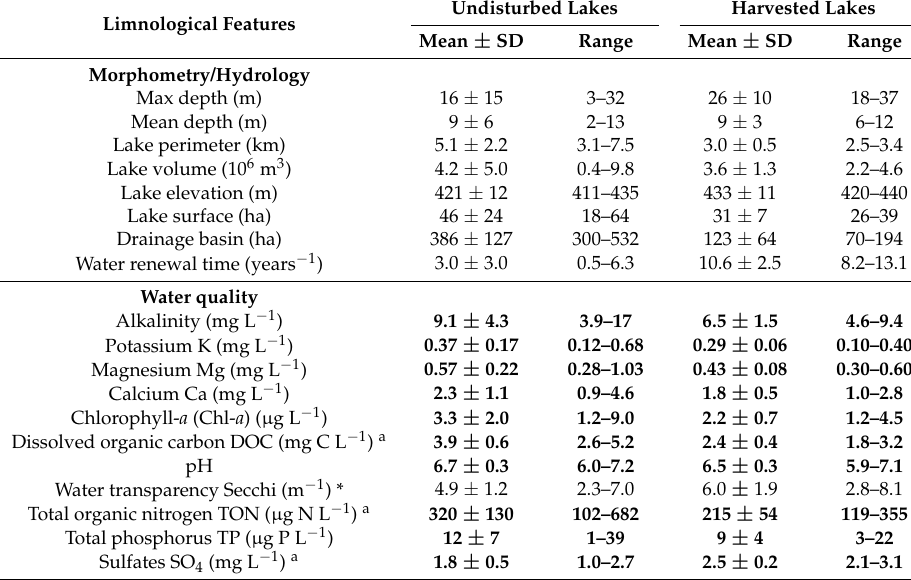
Table 1. Summary of the limnological features (morphometry/hydrology, water quality) for the two groups of lakes (undisturbed and harvested) during the study period. Values in bold indicate significant differences in water quality for harvested and undisturbed lakes (Mann-Whitney U test, p < 0.05). a : significant differences in dissolved organic carbon (DOC), total organic nitrogen (TON), and sulfates (SO 4 ) conserved without